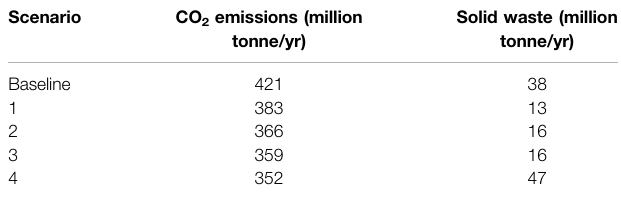
TABLE 10 | Results for the lifecycle analysis of jet fuel and paper production and use. The analysis is based on the paper to jet fuel process with enzymatic